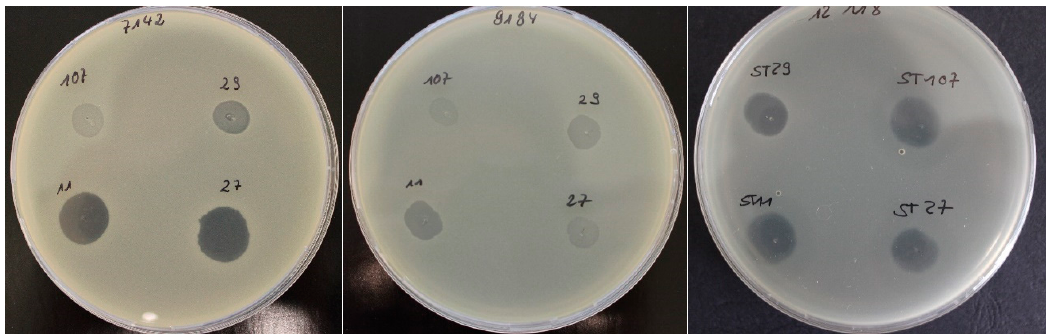
Figure 1. Interpretation of the spot test results.